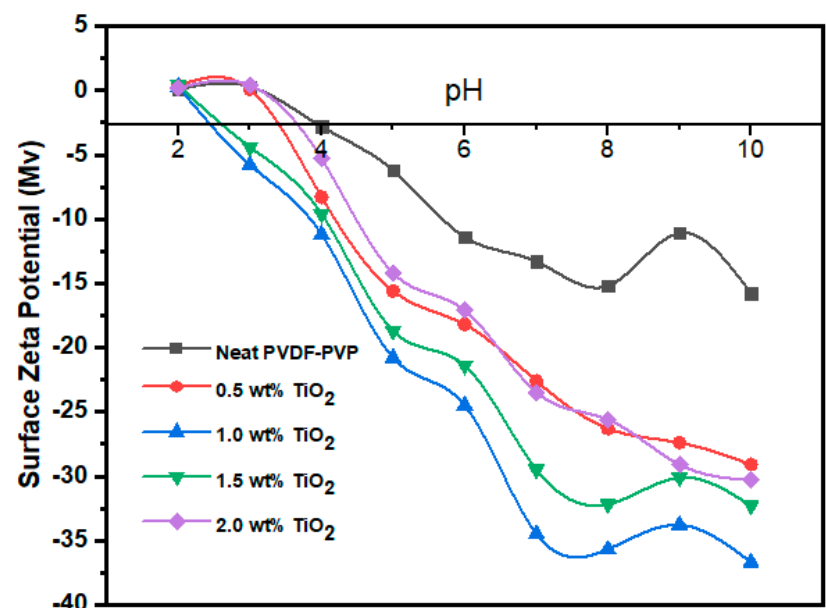
Figure 8. Surface zeta potential of neat PVDF-PVP and modified PVDF / PVP / TiO 2 membrane.